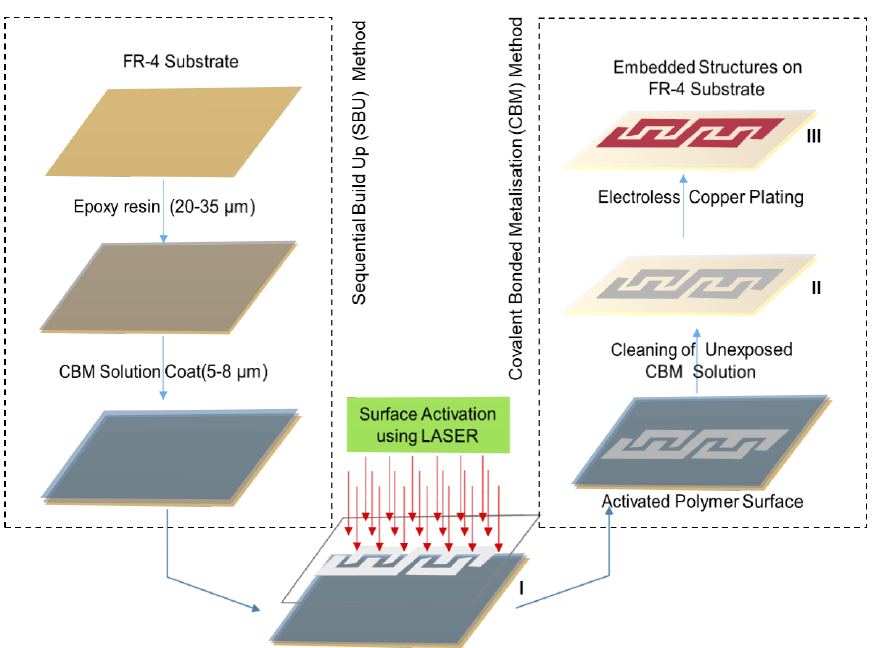
Figure 2. Process flow diagram of the fabrication steps to pattern the geometries.